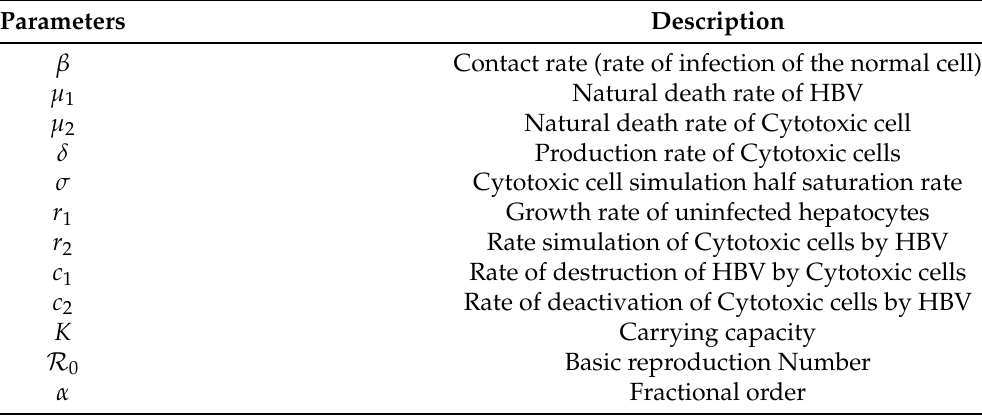
Table 1. The parameters involved in the model equation are described in detail